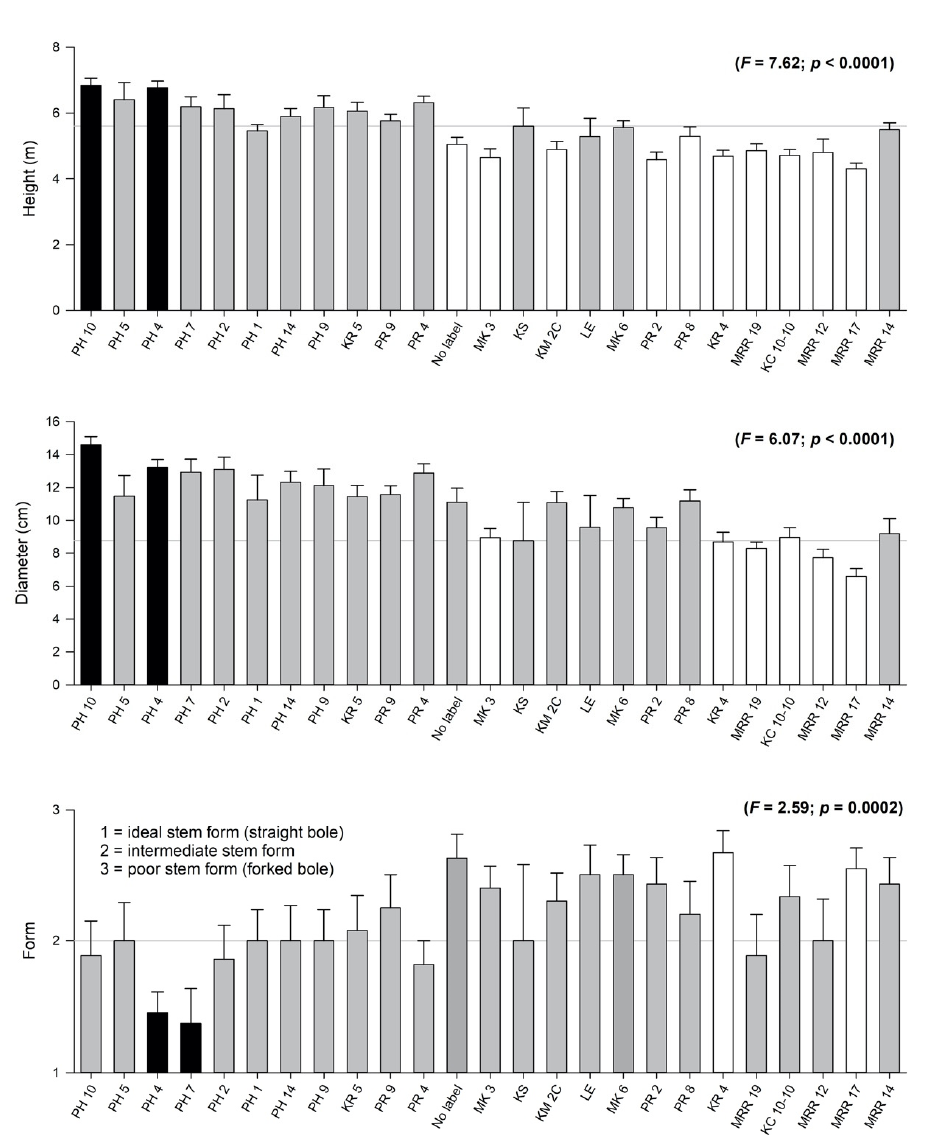
Figure 3. Height, diameter, and stem form of individual A. koa A. Gray families (mean ± SE; n = 20) three years after outplanting. Families represented by black bars had statistically significantly greater heights and diameters and superior form compared to those represented by white bars as determined by analysis of variance via generalized linear mixed models. KS is the susceptible control. Growth from year 1 to 2 varied among families (Figure S4). Seedlings of PH10, PH4, and PR4 had greater height growth (mean ≥ 1.98 m) compared to those of many other families while those of PH10 and PH7 showed greater diameter growth (mean ≥ 4.66 cm). From year 2 to 3, growth did not differ significantly among families (Figure S5).